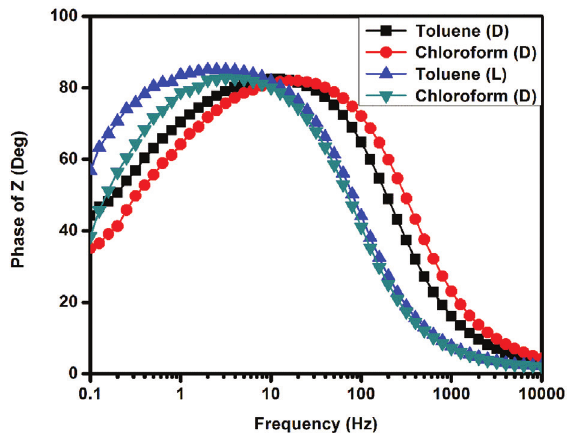
Figure 8: Bode phase plot of IBS thin films developed from homogenous solution of precursors (1) and (2) in toluene and chloroform under illumination and dark